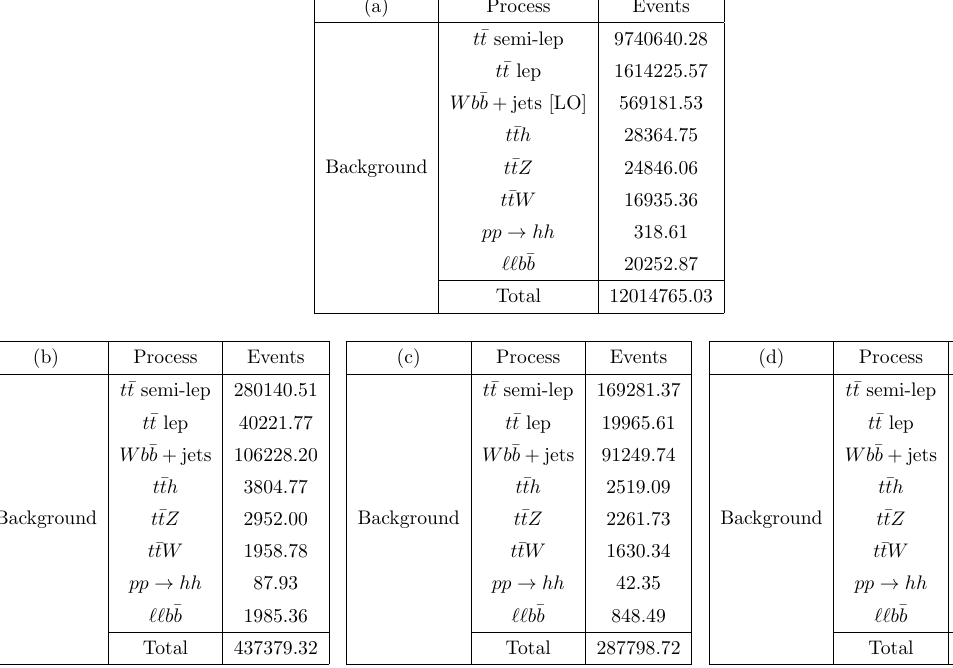
T channel after the BDT analyses